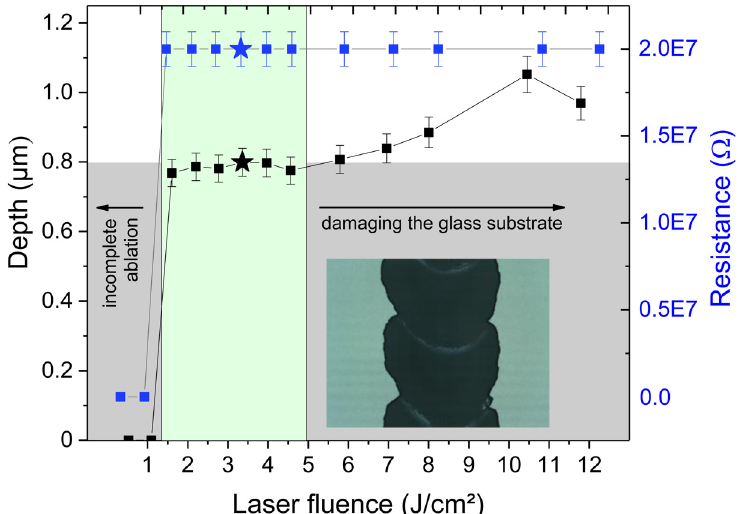
Fig. 2. P1 scribe line depth (left y -axis, black squares) and electrical resistance across the scribe line (right y -axis, blue squares) as a function of the applied laser fl uence. The range of suitable fl uences is marked by the light green area, the selected fl uence with an asterisk. The gray area illustrates the Mo back